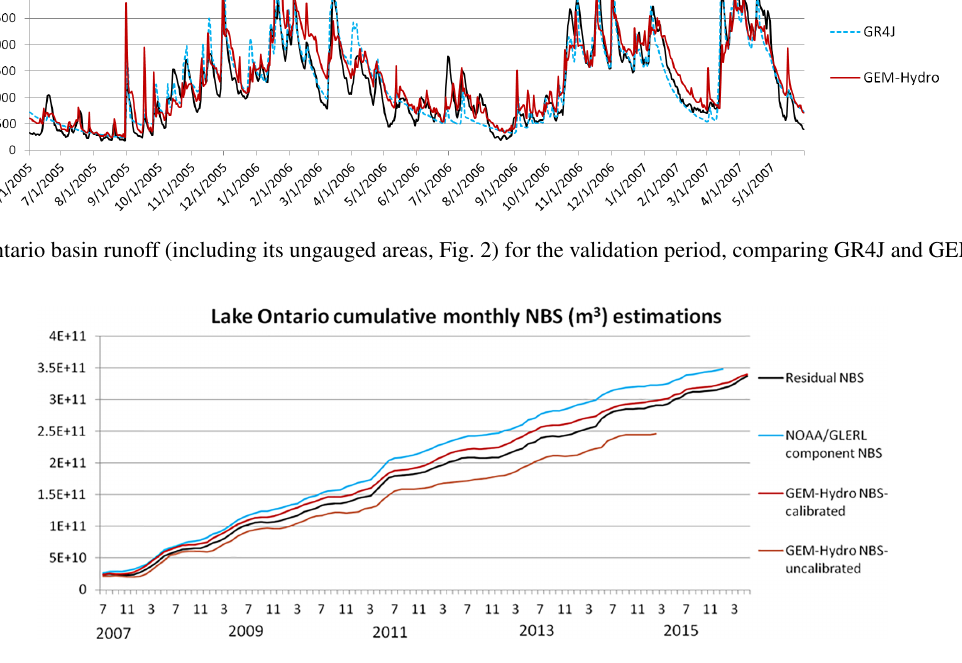
Figure 9. Cumulative Lake Ontario NBS (net basin supply) estimates. Months are shown on the x axis. See text for further